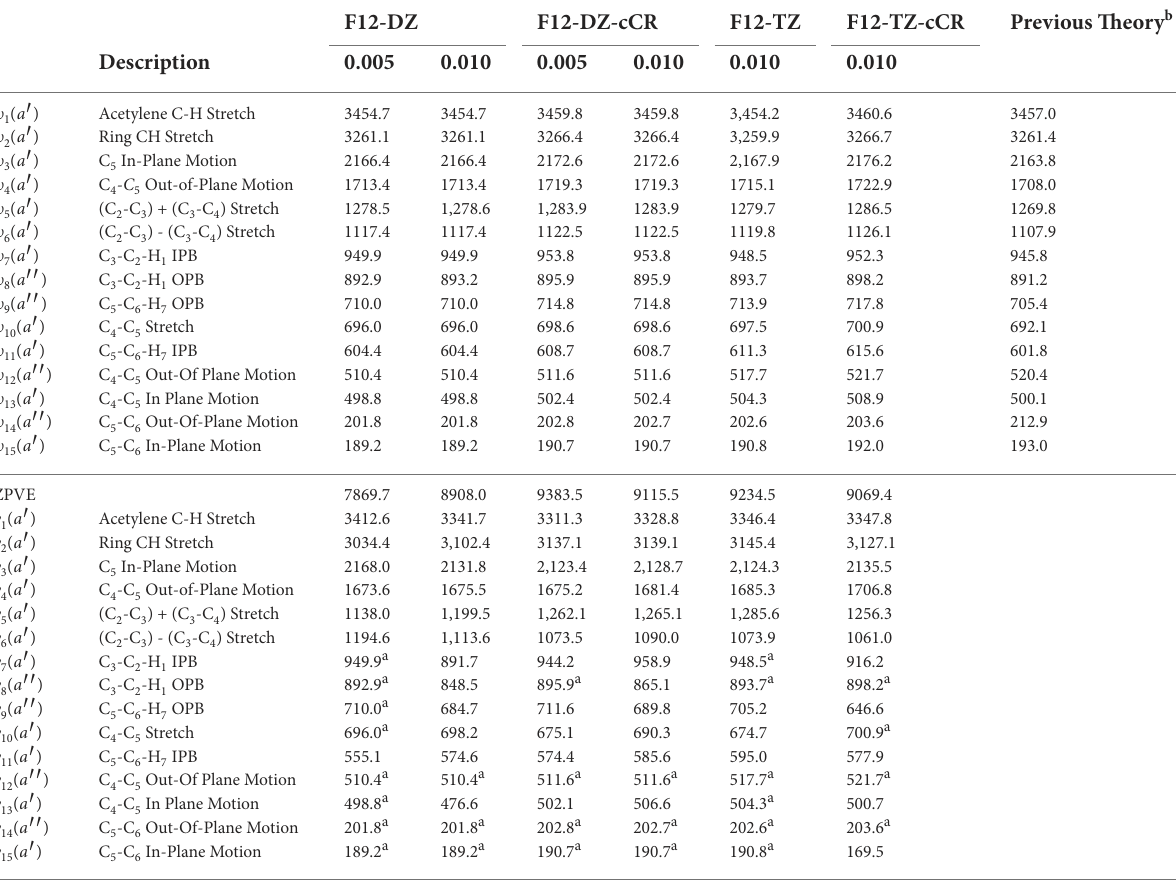
TABLE 6 Harmonicandfundamentalvibrationalfrequenciesof c -C 3 HC 2 Hcomparedtoprevioustheorycomputedatthefc-CCSD(T)/cc-pVTZlevelof theory b